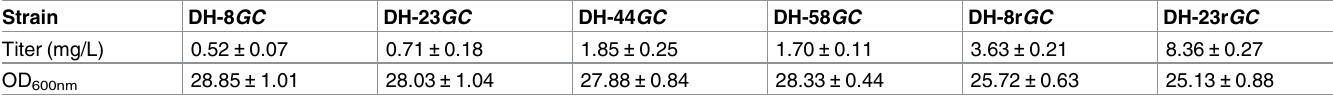
Table 2. Strains used for lycopene